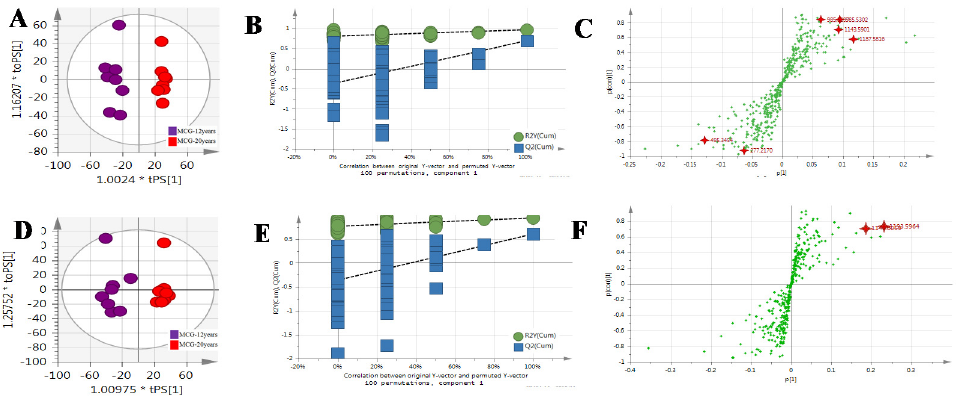
Figure 6. The OPLS-DA/Permutation test/S-Plot of MCG 12 years and MCG 20 years in positive mode ( A / B / C ) and negative mode ( D / E / F ).